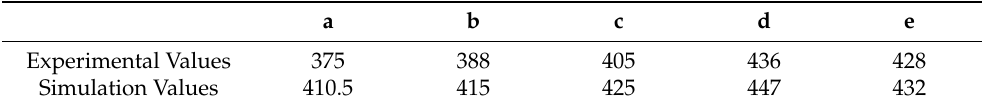
Figure 5. Glass transition temperatures: ( a ) Pure DGEBA, ( b ) DGEBA + SiO 2 , ( c ) DGEBA + SiO 2 + KH550, ( d ) DGEBA + SiO 2 + KH792, ( e ) DGEBA + SiO 2 + TAPS. Table 3. Glass transition temperature (K).